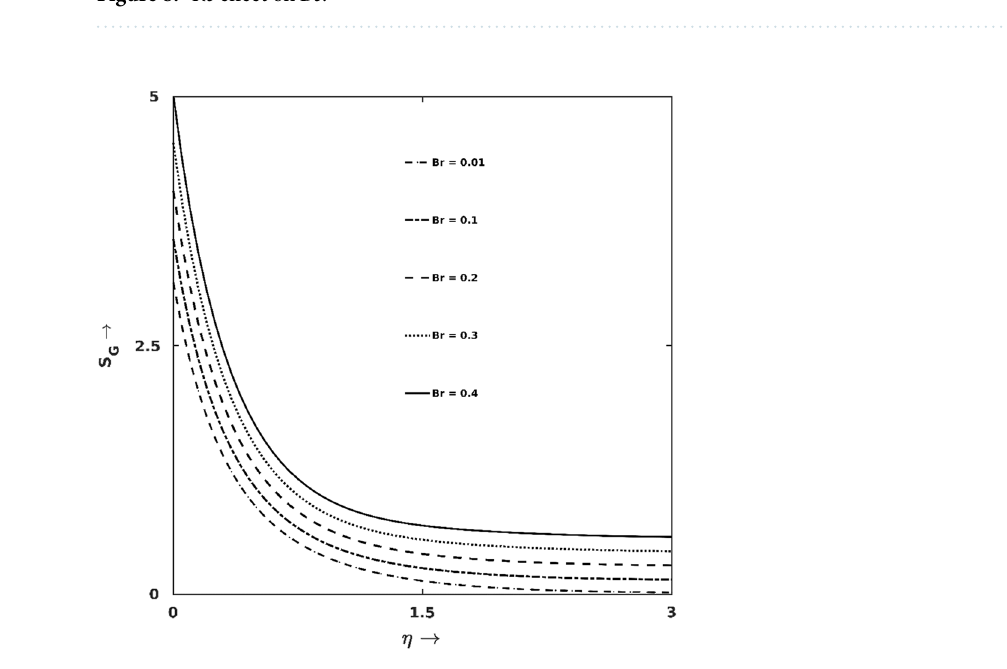
Figure 9. Br effect on S G